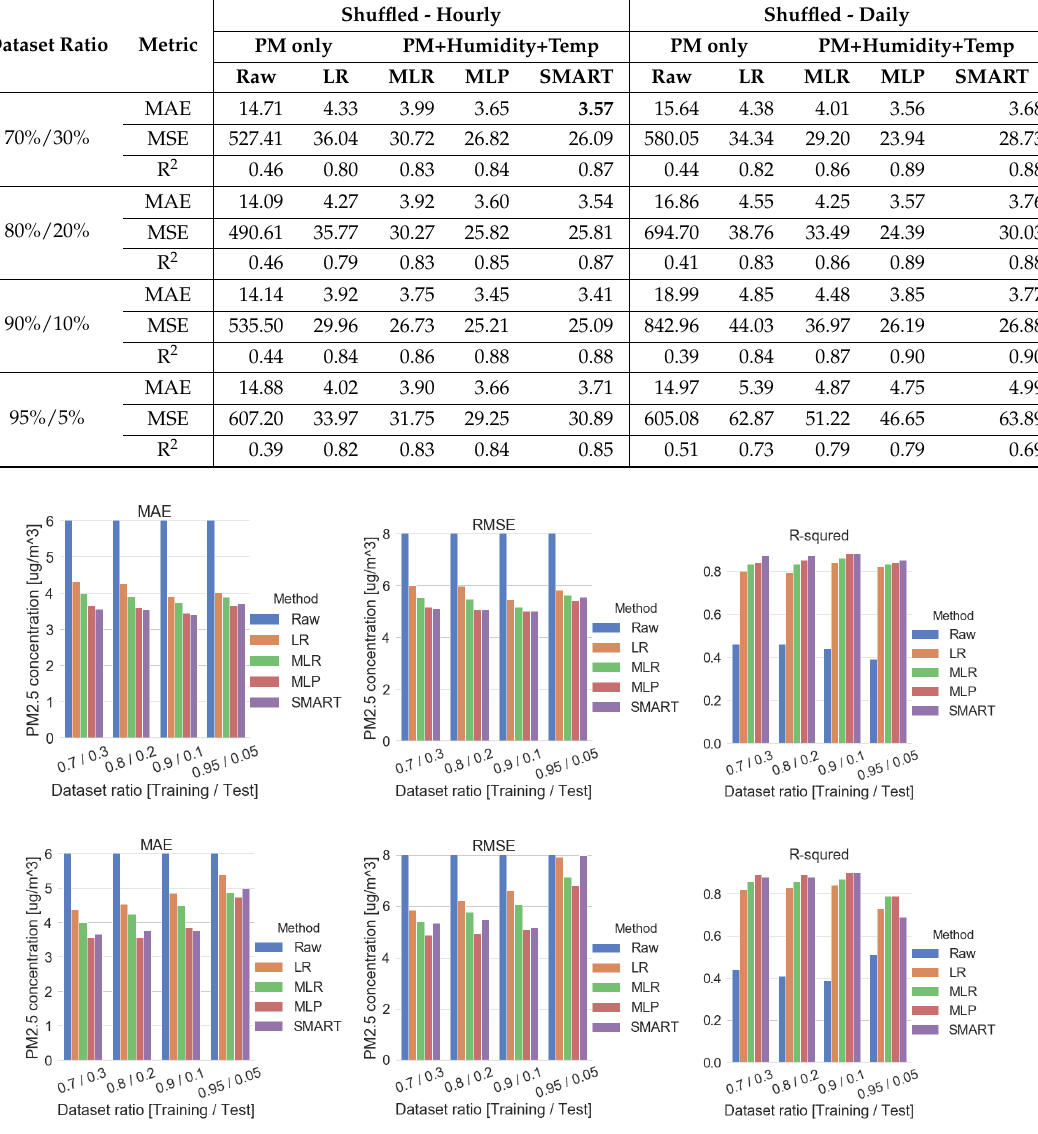
Table A6. Metric analysis for data preprocessing methods (shuffled - hourly/sequential - daily).